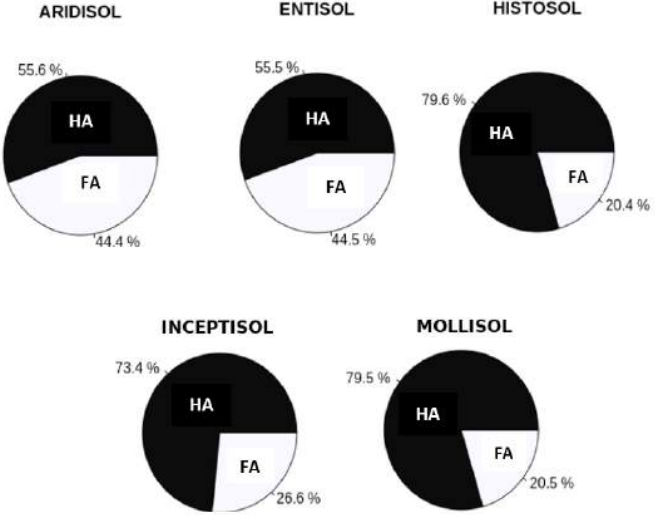
Figure 4: Distribution of fractions of humic acids (HA) and fulvic acids